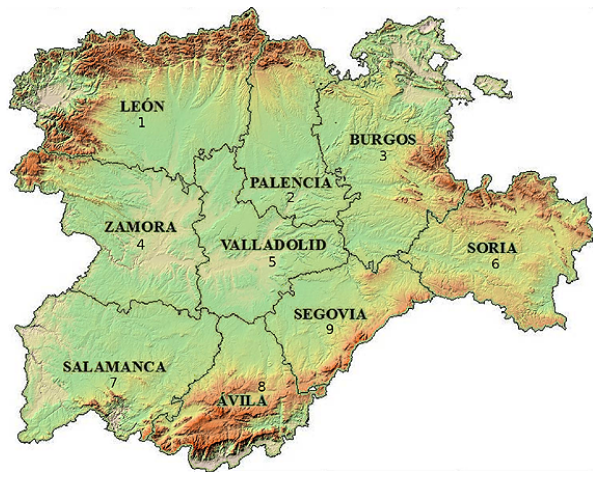
Fig. 2. Provinces of Castile and Leon